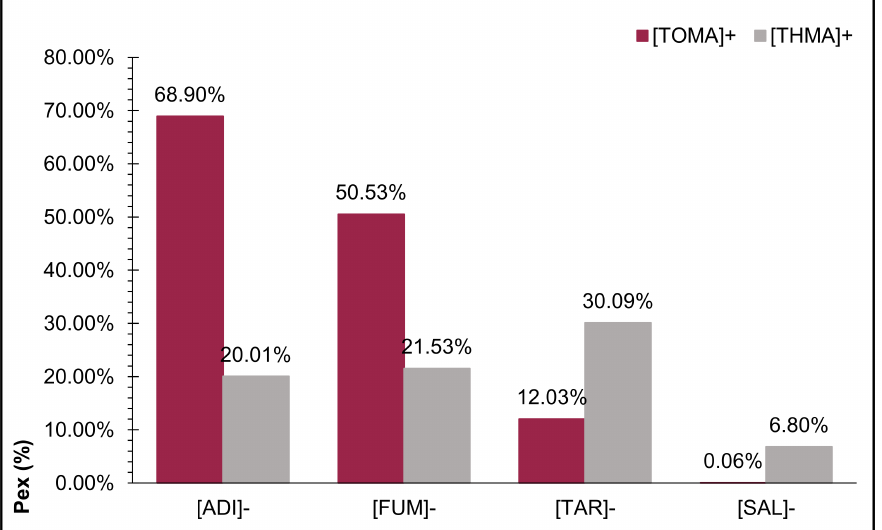
Figure 3. Average results of extraction percentage (P ex ) of betanin from beet juice by [TOMA] + [ADI] − /[TBMA] + [HEX] − in one step. It should be noted that the extraction process of betanin from a natural source did not pass through pre-treatment; consequently, the aqueous solution could contain different sub- stances, such as sugars, proteins, and amino acids, including some bio-active compounds, such as polyphenols, flavonoids, and glycosides, etc., and these kinds of molecules were capable of interacting with the extracting phase, decreasing the recovery percentage of